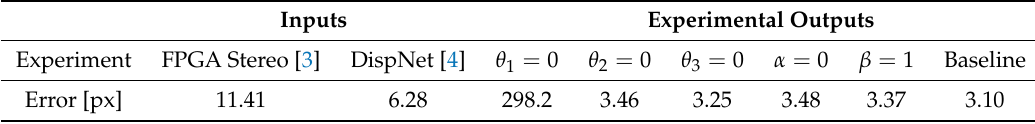
Table 5. Ablation Study on Each Cue Using the Supervised